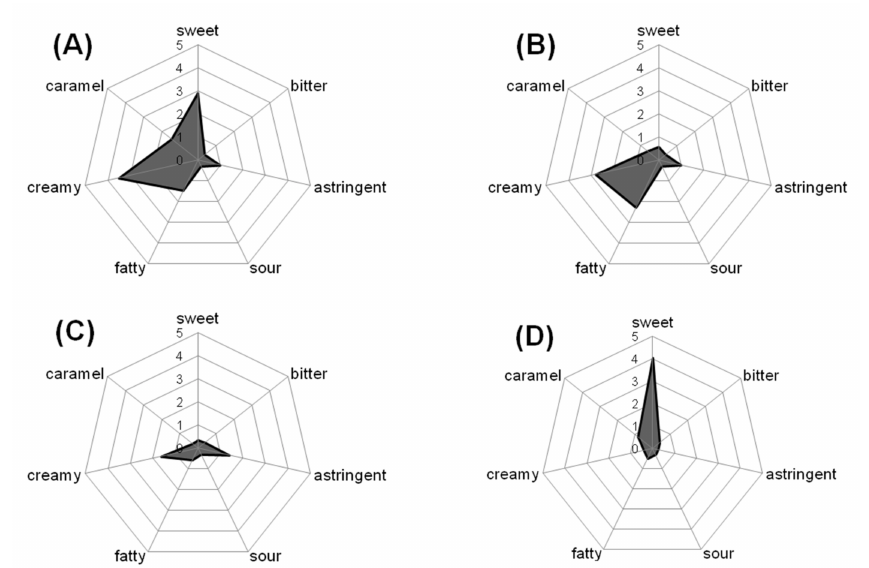
Figure 1. Sensory profiles of ( A ) crumb chocolate, ( B ) fraction I (n-pentane extract) of crumb chocolate, ( C ) fraction II (ethyl acetate extract) of crumb chocolate, and ( D ) fraction III (methanol/water 70/30 v / v extract), all suspended in triglyceride-free lipid emulsion (TFLE).